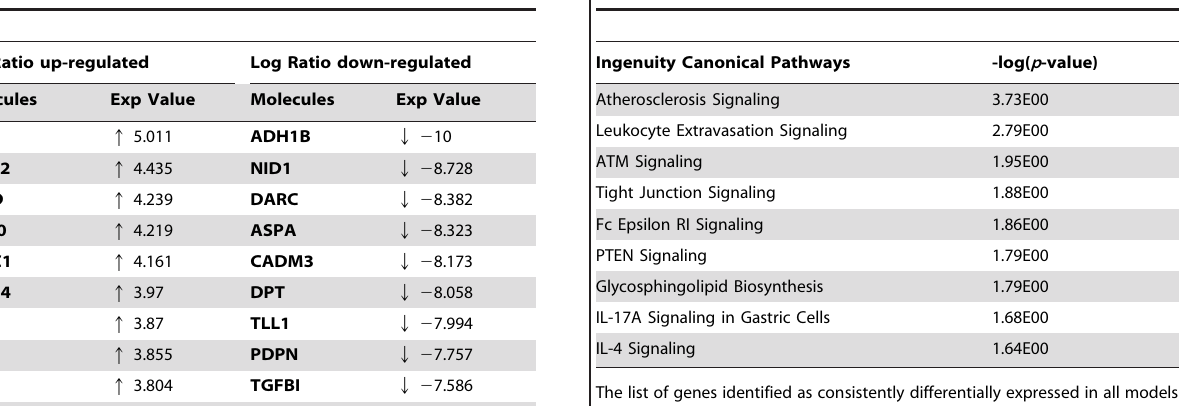
Table 1. Genes with the largest fold change in expression identified in the list of those differentially expressed.